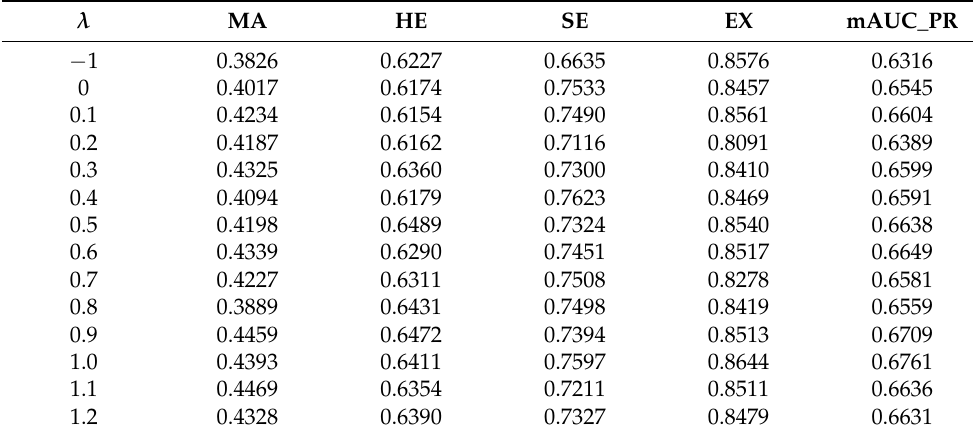
Table 5. Performance comparison of weightage of hybrid loss function.